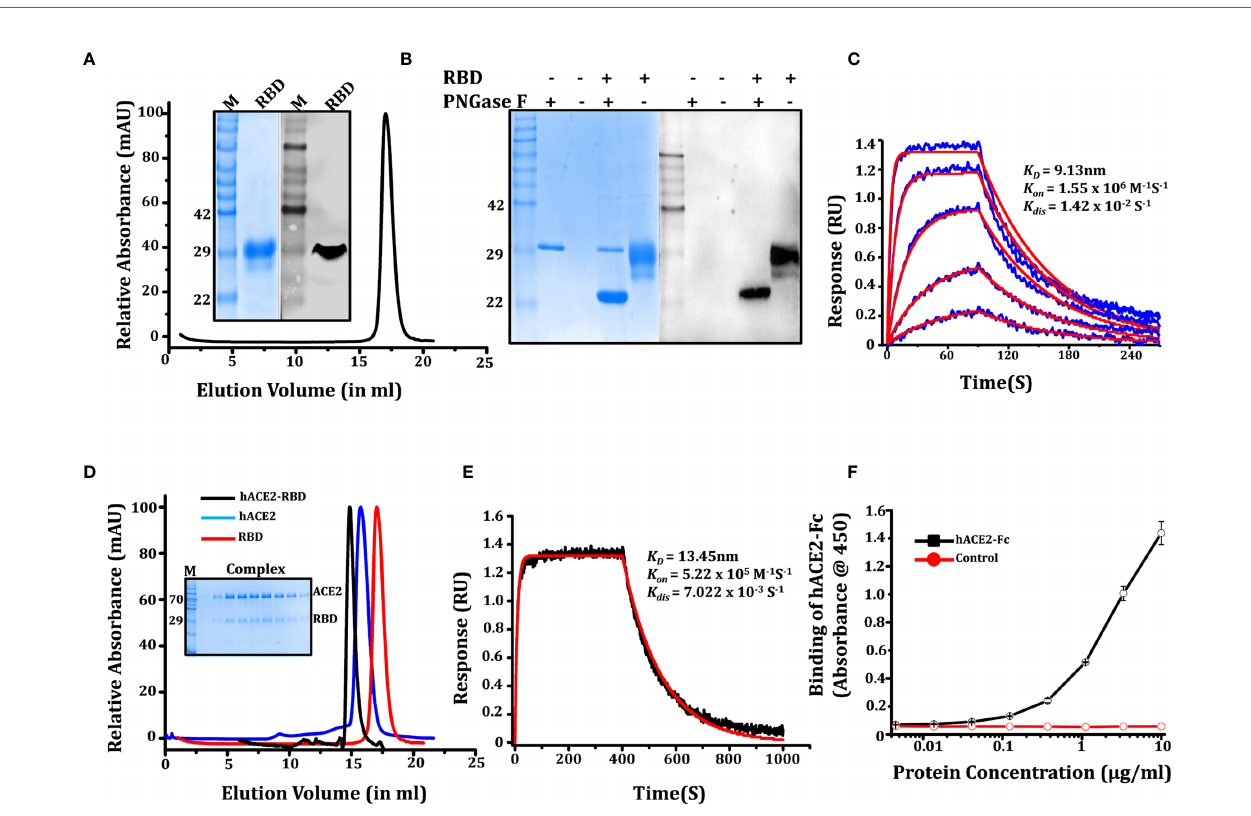
FIGURE 2 | Characterization of SARS-CoV-2 RBD. (A) Puri fi cation of RBD through SEC, protein elutes as single oligomeric population with peak position at 17.04 ml, inset showing SDS PAGE and western blot (anti-his antibody) of puri fi ed RBD recognizing a 32 kDa band. (B) SDS-PAGE and western blot showing the glycosylation status of the RBD, western blot con fi rming the glycosylated and de-glycosylated conformation of RBD. (C) Binding kinetic evaluation of mAb CR3022 to RBD at nanomolar af fi nity, the RBD used as analyte in various concentrations (shown in blue color graphs). The red solid line shows the fi tted curve. (D) Gel elution pro fi le of RBD, hACE2-His, and RBD-hACE2 complex shows a shift in the peak of the complex toward higher molecular weight oligomeric conformation, SDS gel in inset showing the co-elution of RBD and hACE2 as a complex. (E) Binding of biotinylated hACE2 with RBD on BLI platform, our result shows that ACE2 binds ef fi ciently to RBD with K D of 13.43 ± 0.80nM. (F) Dose-dependent binding response of hACE2-Fc with RBD measure with